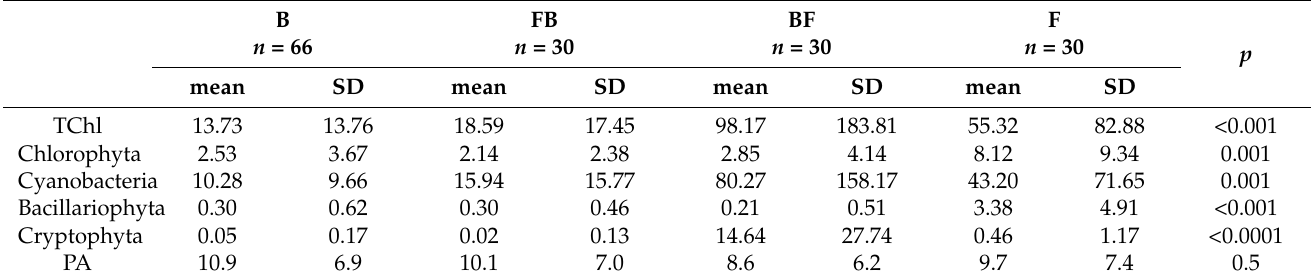
Table 3. Mean chlorophyll-a concentration ( µ g L − 1 ± SD) of groups of phytoplankton and their photosynthetic activity (PA, %) in various types of Baltic coastal lakes and results of the one-way ANOVA evaluating variation between them. TChl = total chlorophyll-a concentration, PA = photosynthetic